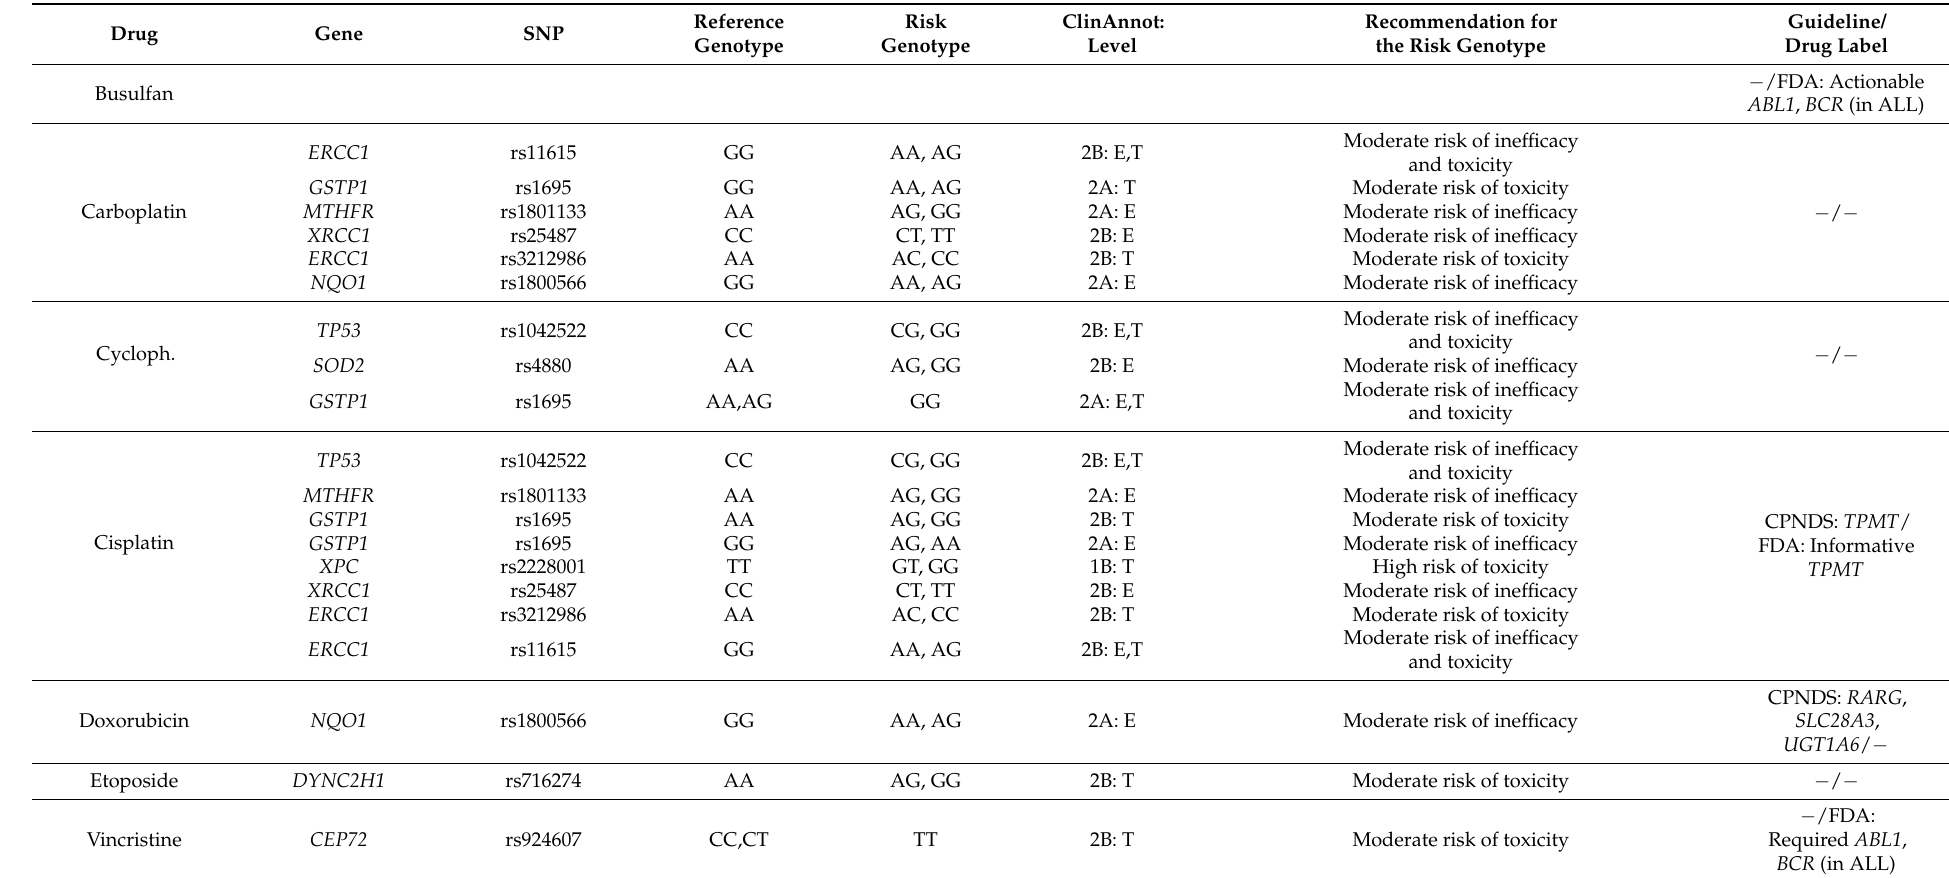
Table 1. Drugs included in NB treatment with clinically valuable PGx recommendations. The drugs included meet at least one of the clinical implementations three pillars-criteria: PGx included in Drug Label, PharmGKB Clinical Annotations Levels of Evidence 1 and 2, the existence of Clinical Implementation Guidelines published by relevant consortia. ALL: Acute Lymphoblastic Leukemia CPNDS: Canadian Pharmacogenomics Network for Drug safety, Cycloph: Cyclophosphamide, FDA: US Food and Drug Administration. Symbol − for guideline and drug label: lack of information.